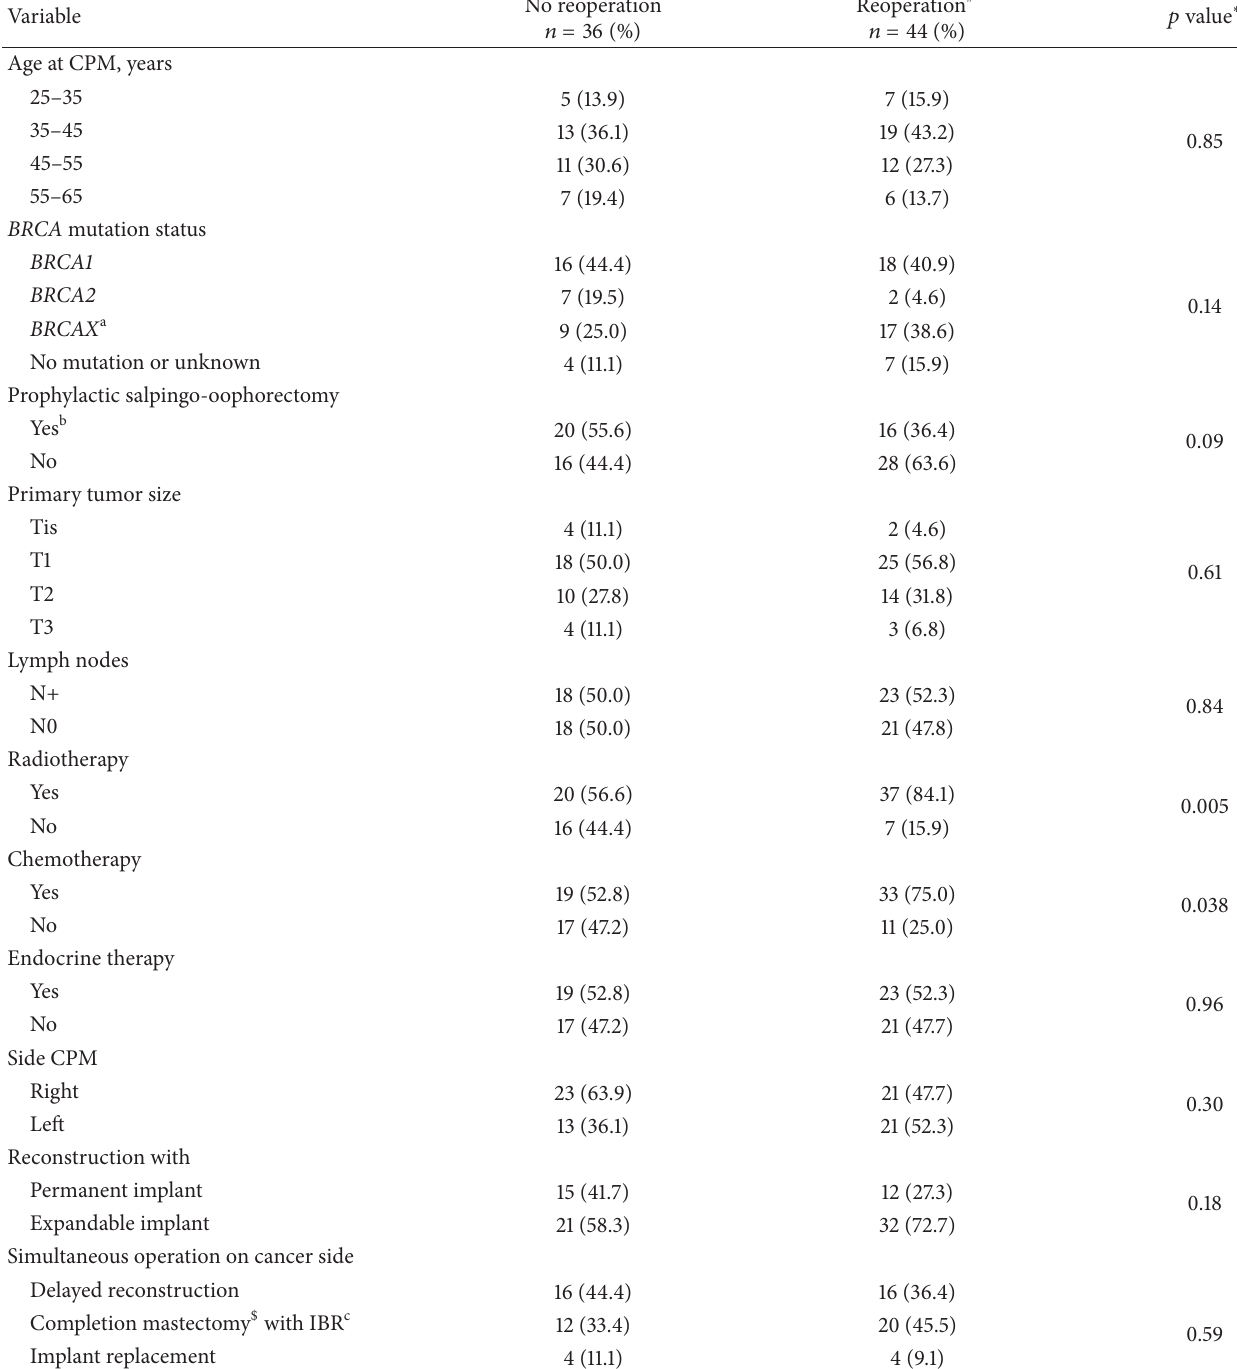
Table 1: Demographic and clinical data for all eligible patients according to reoperation after CRRM ( 𝑛 = 80 ).